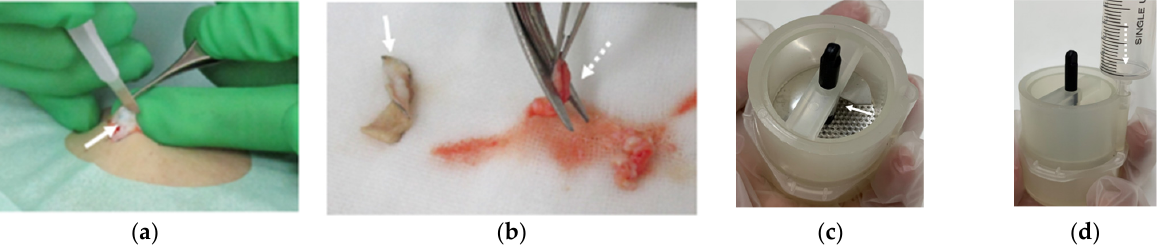
Figure 2. Preparation of the micrograft (using Rigenera ® system and Rigeneracons). ( a ) Harvesting of tissue: The tissue sample was harvested and divided into two layers, the epidermal layer and the dermal-subdermal layer. The arrow shows the epidermis collection from the superficial layer of the dermis. ( b ) Harvested tissue: Epidermal layer (solid arrow) and the dermal-subdermal layer (dashed arrow) are shown. The tissue was cut into 2–3 mm size using a scissor. ( c ) Sample tissues are placed inside the Rigeneracons (solid arrow). ( d ) 16 mL physiological saline solution is added from the side hole (dashed arrow). Micrograft suspension is prepared by cutting tissues into fragments of 80 μ m using the Rigenera ® system (photo not shown).